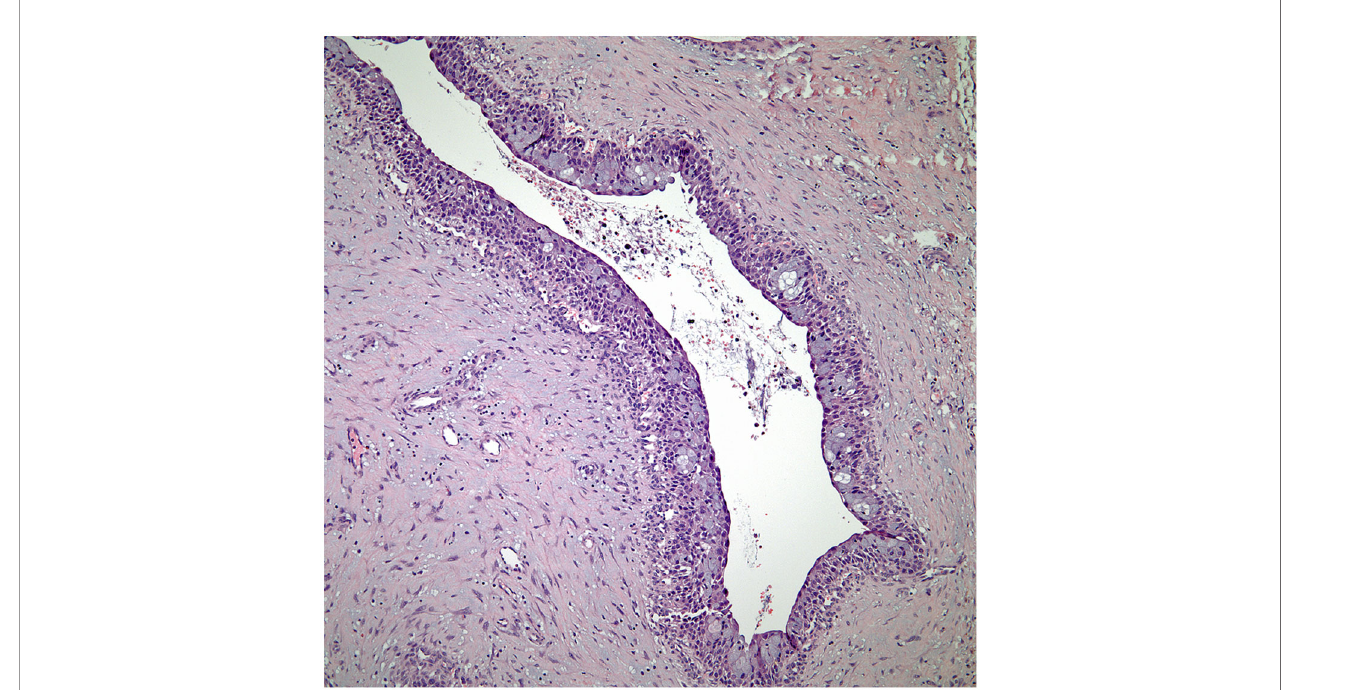
FIGURE 7 | Thymic low-grade mucoepidermoid carcinoma with cystic